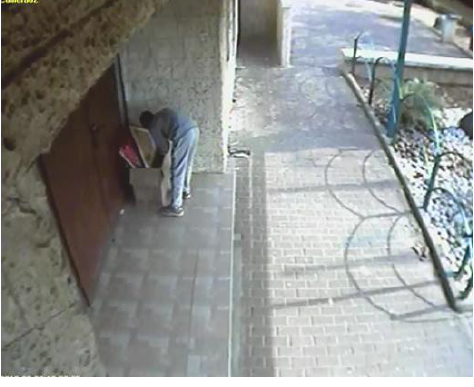
Figure 2. Example of an irregular event with a strong visual signature: single person loitering near the community center main entrance door (resulted in a foiled arson event, courtesy: security department of the city of Nes Ziyona,